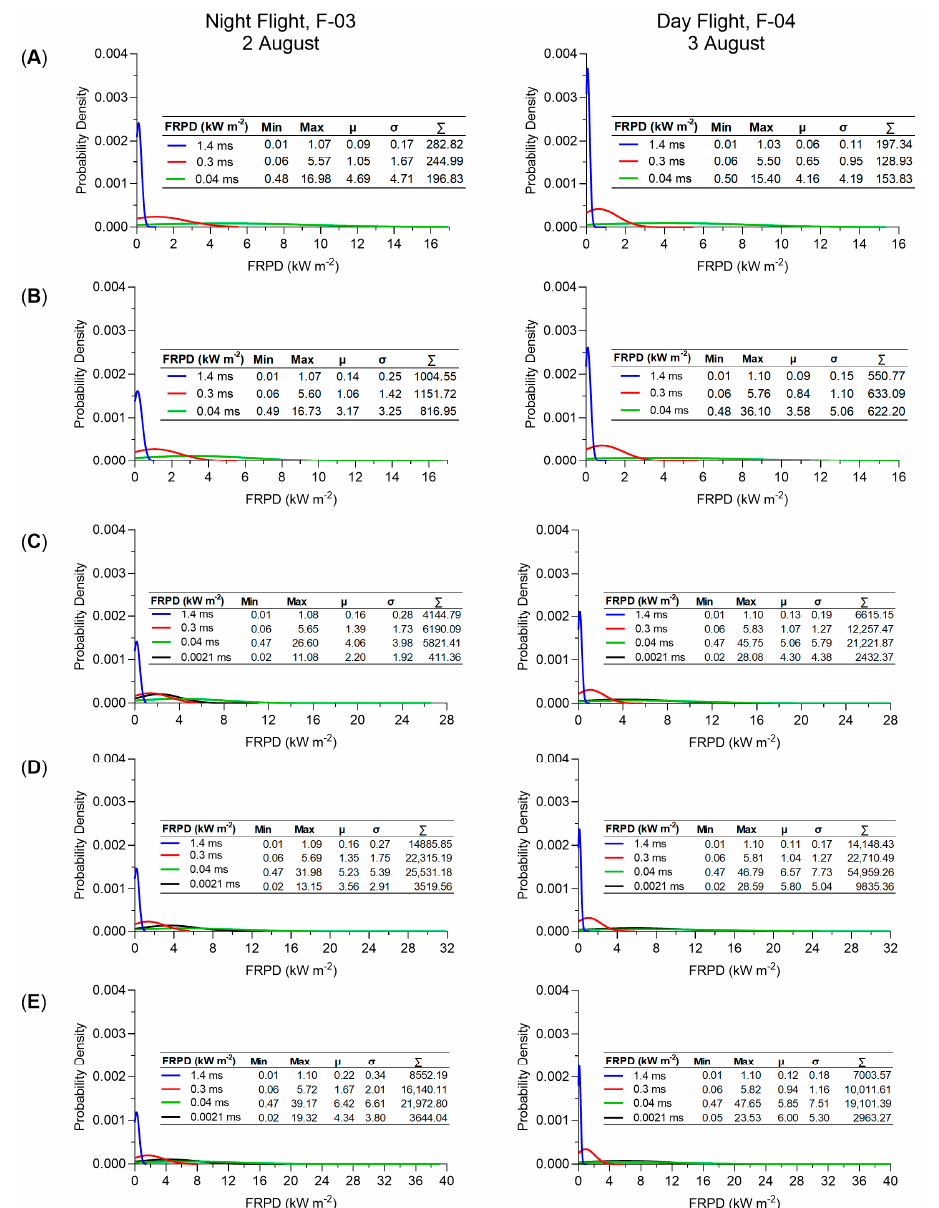
Figure 14. Probability density and statistics (minimum, maximum, mean, standard deviation and sum) of FRPD (kW − 2 ) at the different integration times (i.e., 1.4 ms, 0.3 ms, 0.04 ms, and 0.0021 ms) for ( A ) FL-02, ( B ) FL-03, ( C ) FL-04, ( D ) FL-05, and ( E ) FL-06 acquired during night flight (F-03) and day flight (F-04) for the 2017 campaign.